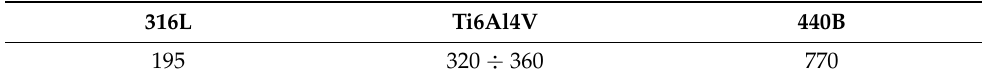
Table 4. Vickers hardness of substrate materials used in the study